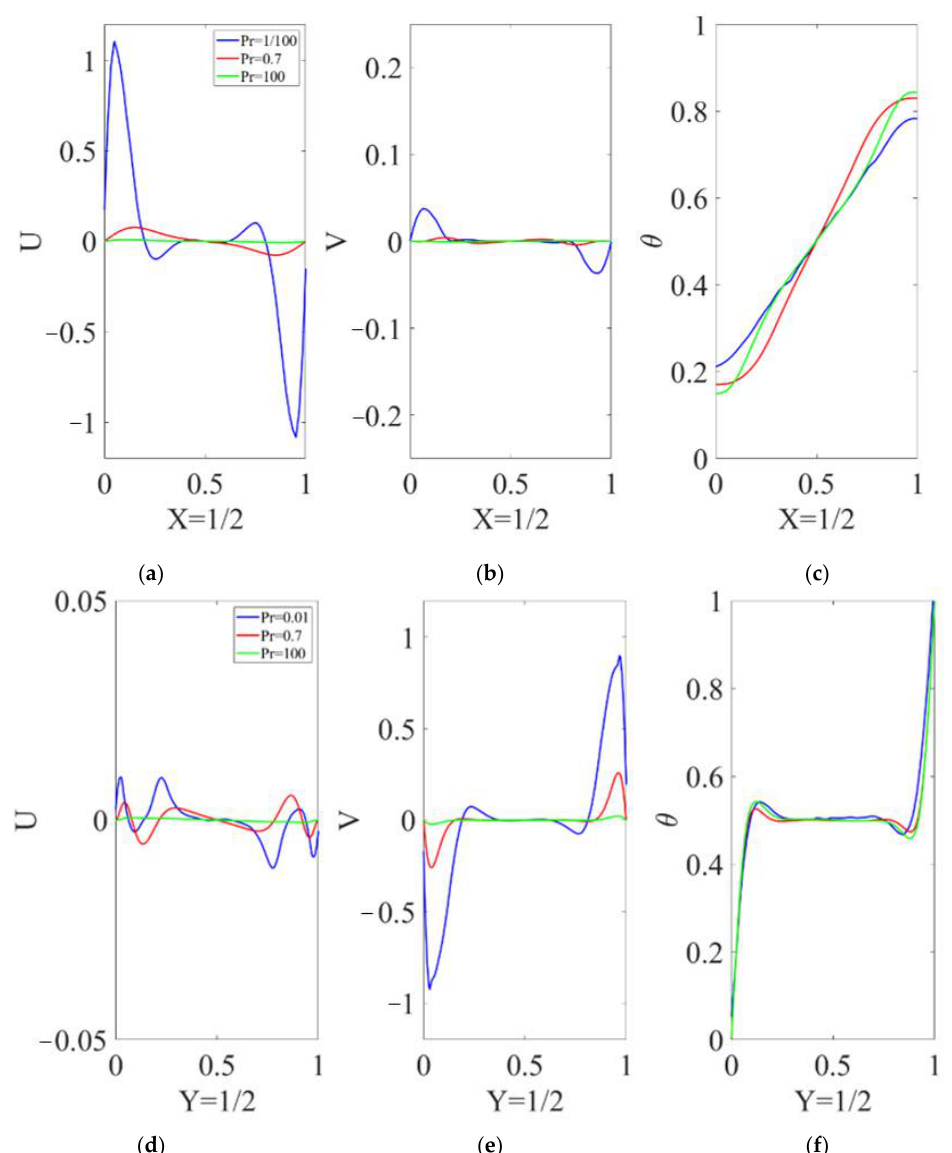
Figure 5. Non-dimensional velocity in x-direction ( a , d ), in y-direction ( b , e ) and temperature profiles ( c , f ) along the midsection of the cavity (X = 1/2 and Y = 1/2) for different Prandtl numbers and Ra = 10 6 . All the results for Pr = 0.7 and Pr = 100 are reported in steady-state conditions, while for Pr = 0.01, the results are reported for a long-time average of the transient velocity profiles.